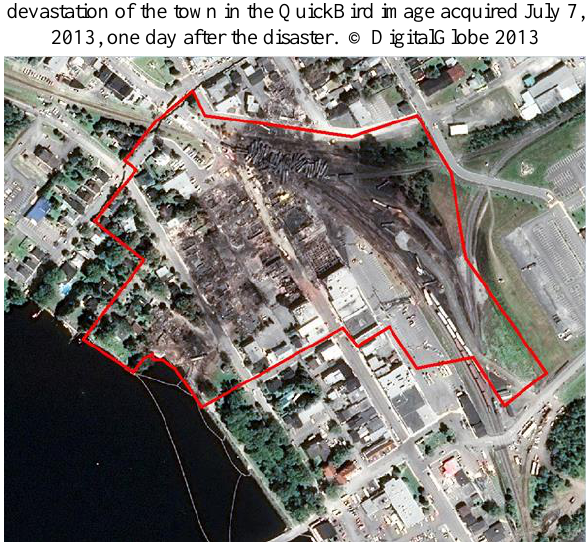
Figure 5. Pléiades image acquired one week post derailment on July 13, 2013. © CNES 2013, Distribution Airbus